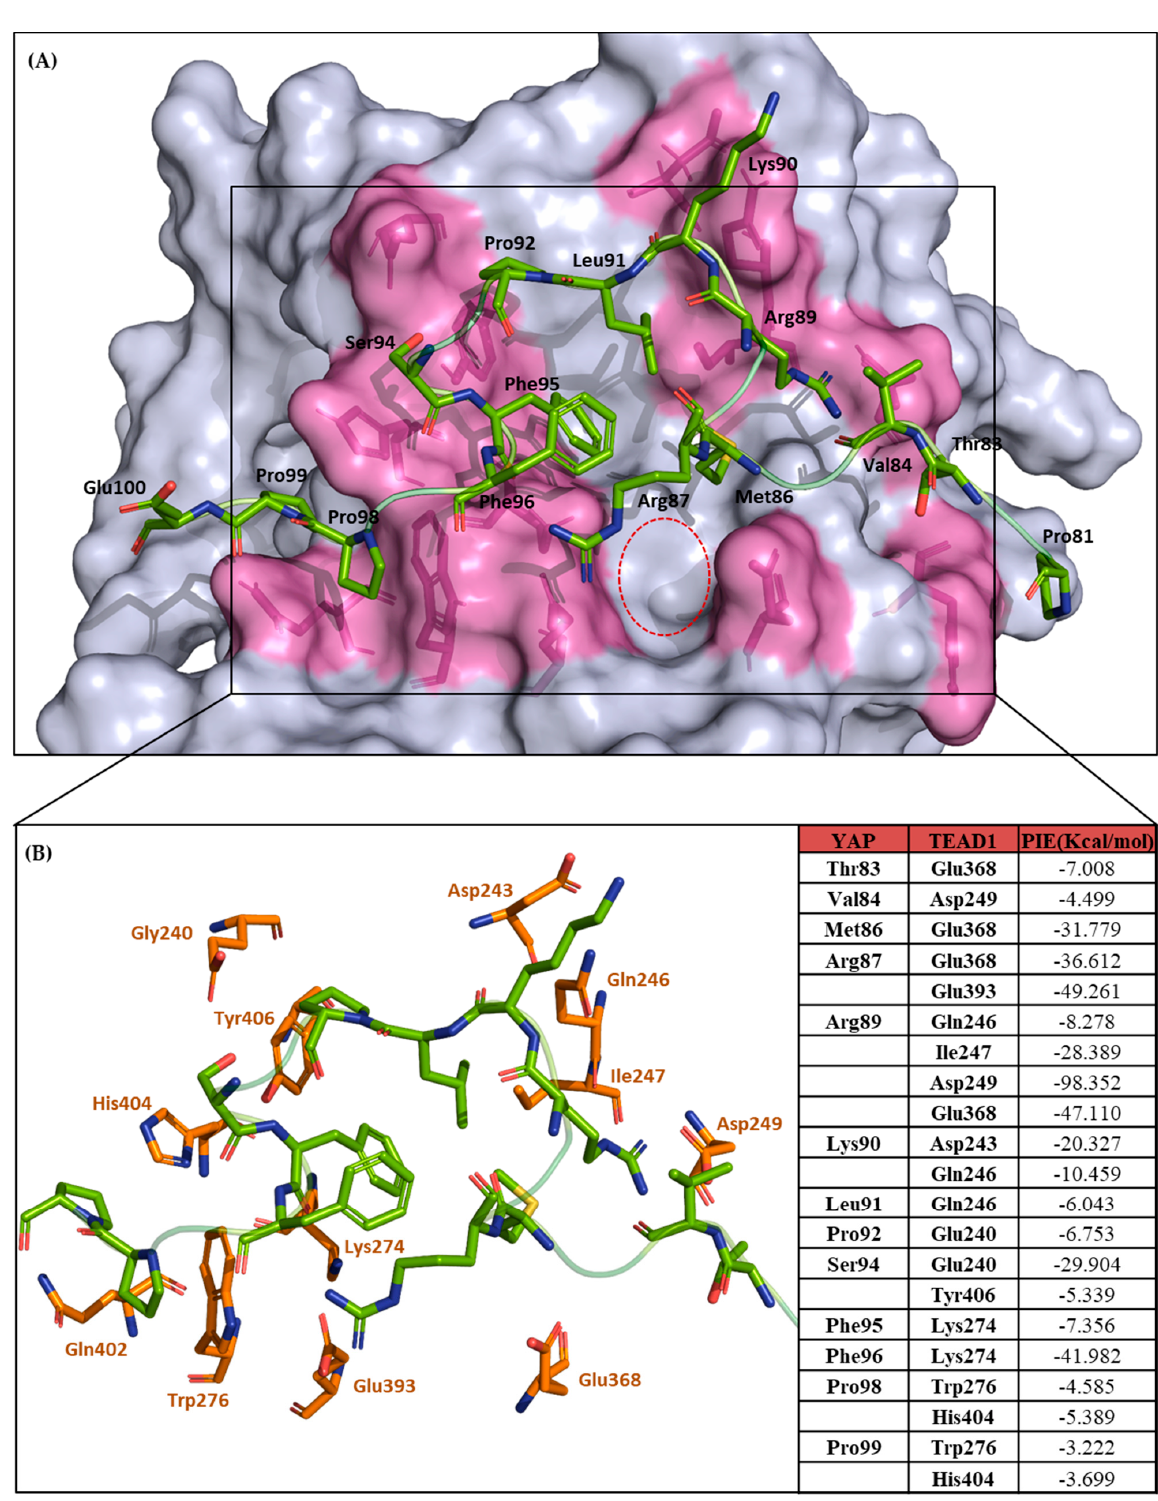
Figure 3. FMO analysis for interface 3 of YAP–TEAD1 PPIs. ( A ) Hot spot residues of YAP, namely, Thr83, Val84, Met86, Arg87, Arg89, Lys90, Leu91, Pro92, Ser94, Phe95, Phe96, Pro98, and Pro99, are shown as green sticks. The green loop indicates YAP, the light greyish-blue TEAD1, and raspberry color indicates the TEAD1 interaction domain for YAP hot spot residues in interface 3. ( B ) TEAD1 hot spot residues in interface 3 are shown as orange sticks. Details of PIEs are described in the right panel.